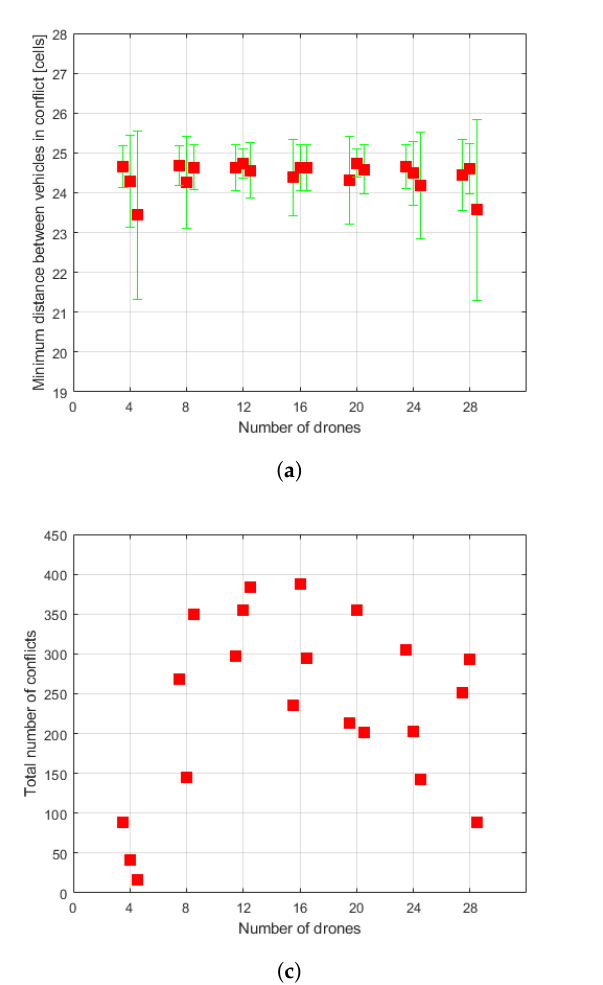
Figure 9. Statistical measures collected through simulations. Red squares represent mean values, while green ranges indicate mean absolute deviation. ( a ) Real flight time/useful time ratio in outbound missions. ( b ) Real flight time/useful time ratio in return missions. ( c ) Traveled distance in outbound missions. ( d ) Traveled distance in return missions. ( e ) Number of conflicts in outbound missions. ( f ) Number of conflicts in return missions.